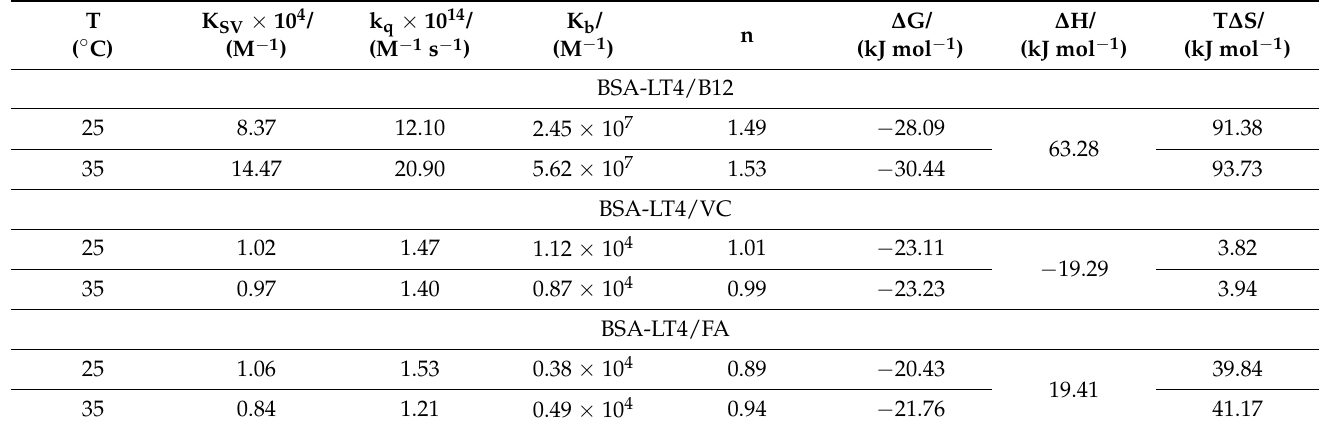
Table 1. The parameters of the interaction of vitamin C, folic acid and vitamin B12 with BSA- LT4